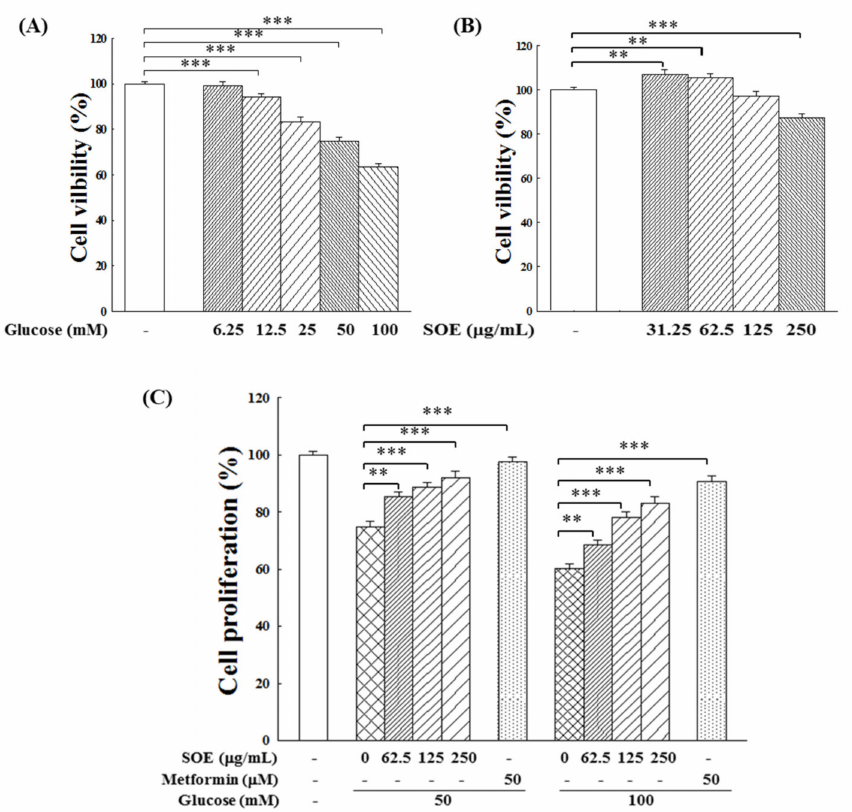
Figure 1. Effects of glucose and SOE on the cell viability and proliferation of RIN-m5f β -cells. ( A ) Effect of glucose at different concentrations on the viability of RIN-m5f cells. ( B ) Effect of SOE at different concentrations on the viability of RIN-m5f cells without adding glucose. ( C ) Effect of SOE at different concentrations on the proliferation of RIN-m5f cells stimulated by treatment of 50 mM or 100 mM glucose. β -Cells were cultivated in 96-well plates at a density of 1 × 10 4 cells/well for 24 h; then the indicated concentration of glucose and/or SOE was added. After 24 h treatment, the cell viability was assessed using an MTT assay kit and detected at 570 nm by an ELISA reader. The control group was the RIN-m5f cells grown without glucose stimulation and SOE treatment. The number of cells at 24 h cultivation of this group was set as 100%. The experimental data were calculated from the results of five repeated experiments. The statistically significant differences compared to the control or the vehicle (group 0) are expressed as ** p < 0.01, and *** p < 0.001. The positive control was 50 µ M